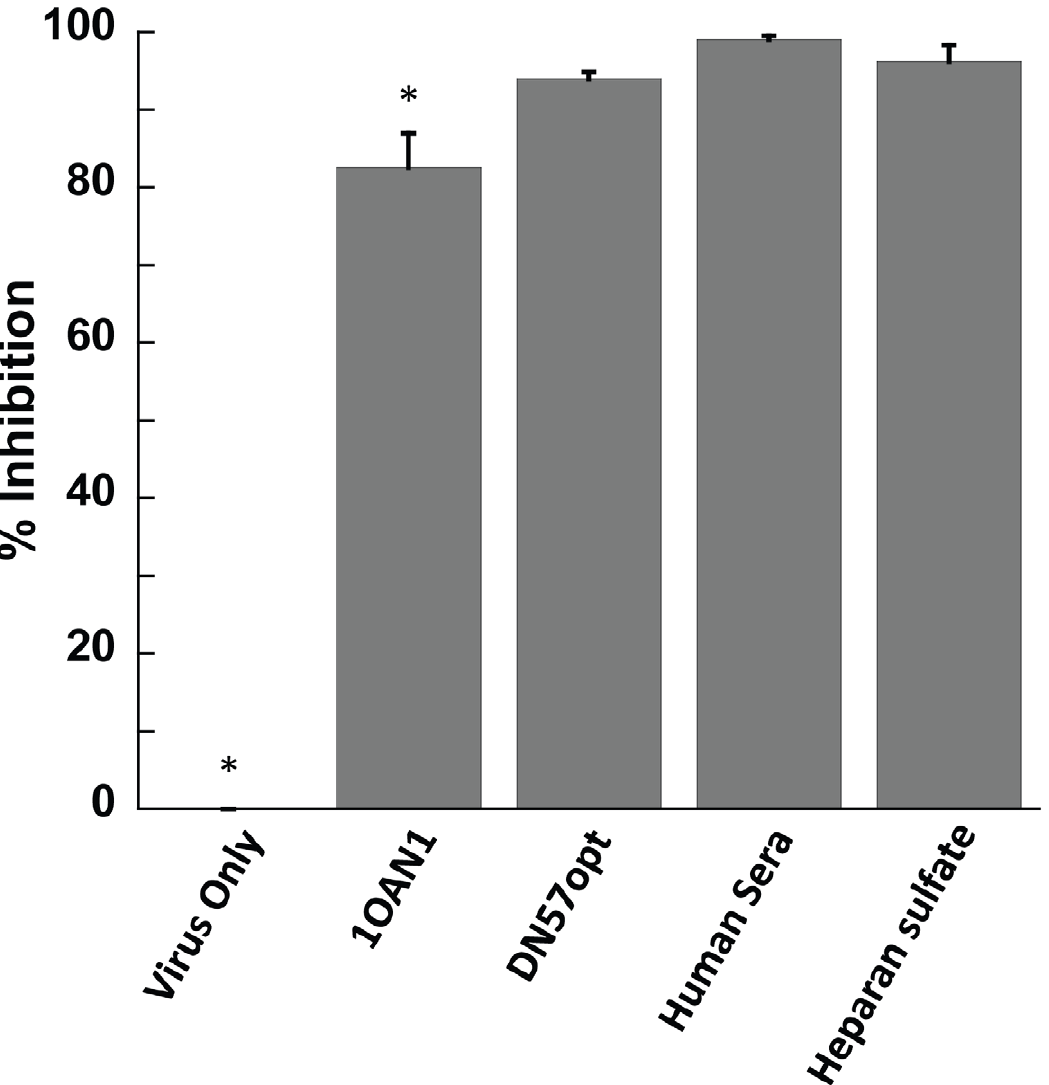
Figure 7. Quantitative reverse transcriptase PCR virus:cell binding. Virus pre-incubated with either DN57opt or 1OAN1 shows reduced binding to cells compared to control virus without peptide. Pre-incubation of virus with pooled human anti-dengue serum or heparan sulfate similarly shows reduced cell binding. * Indicates a significant difference (p , 0.05) from all others by 1-way ANOVA followed by Tukey’s posthoc test.